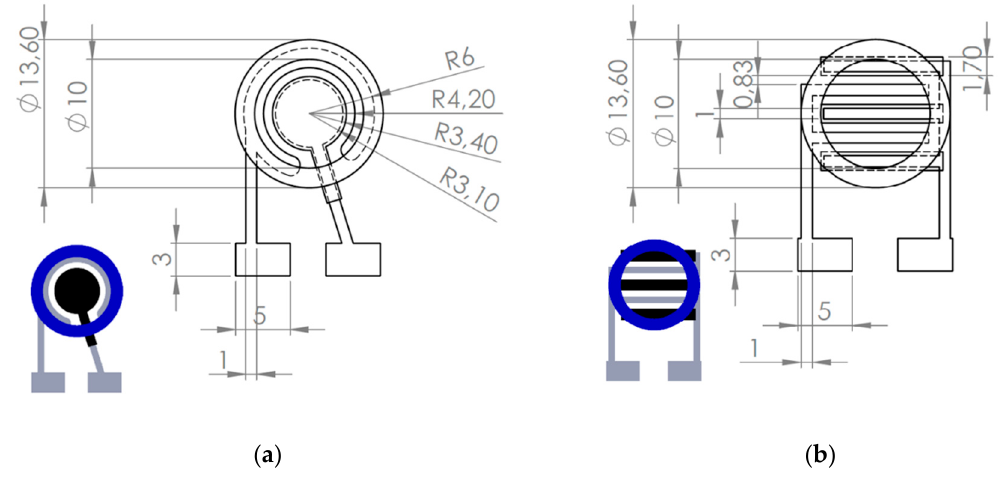
Figure 1. Schematic diagram of the screen-printed electrode chips ( a ) round-shaped (RS) and ( b ) line / finger (LF) electrodes. The anode was screen printed with silver (Ag) ink (grey). The cathode was screen printed with ethyl cellulose-carbon black (EC-CB) or polystyrene- carbon black (PS-CB) paste (black) on top of the Ag layer on working electrode areas. The hydrophobic ring was screen printed with dielectric paste (blue). Dimensions are given in mm. The cathode area (radius = 3.4 mm) of the RS is 46% of the sample area (r = 5 mm) and in LF electrode it is 40%.